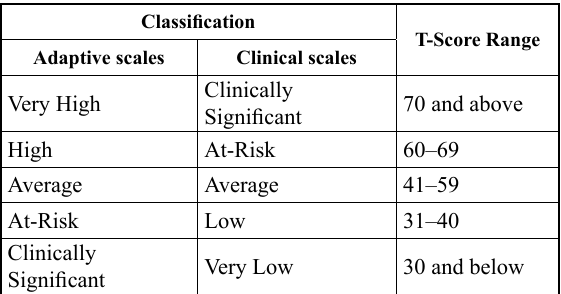
Table 1. Scale and composite score